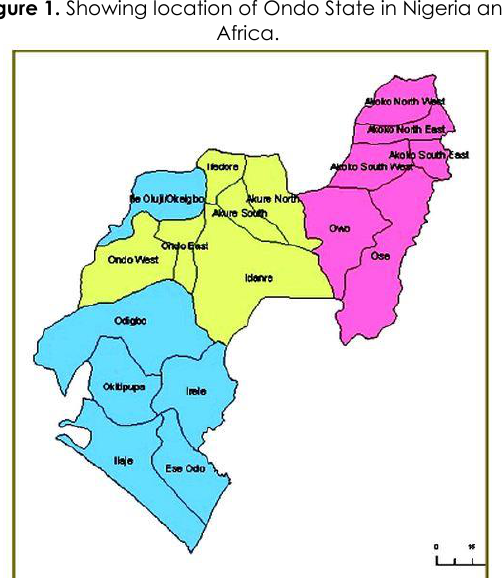
Figure 2. Showing the various Local Government Areas in Ondo State,